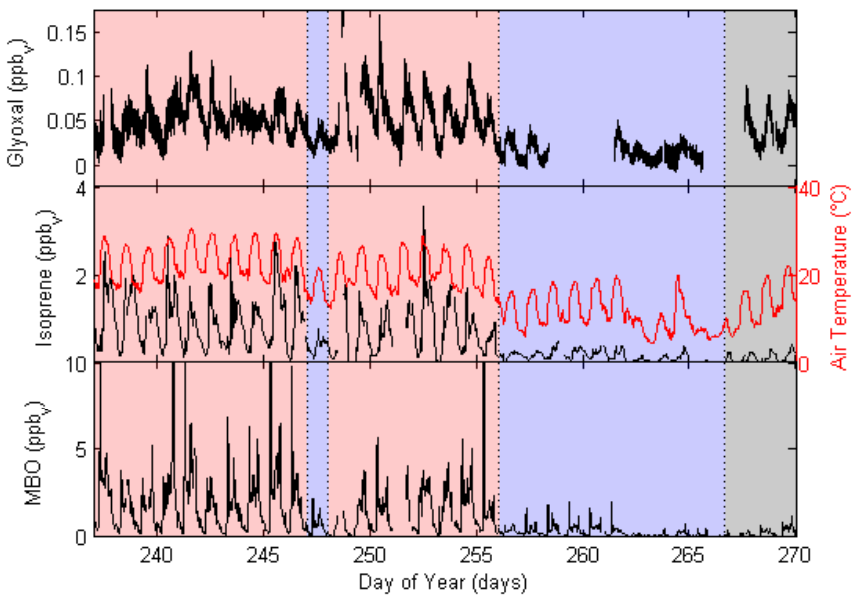
Fig. 1. Overview of glyoxal measurements, separated by temperature period (red, blue, gray corresponding to hot, cold, and intermediate period). Isoprene and MBO, the most important glyoxal BVOC precursors, are included along with air temperature on the center axis on